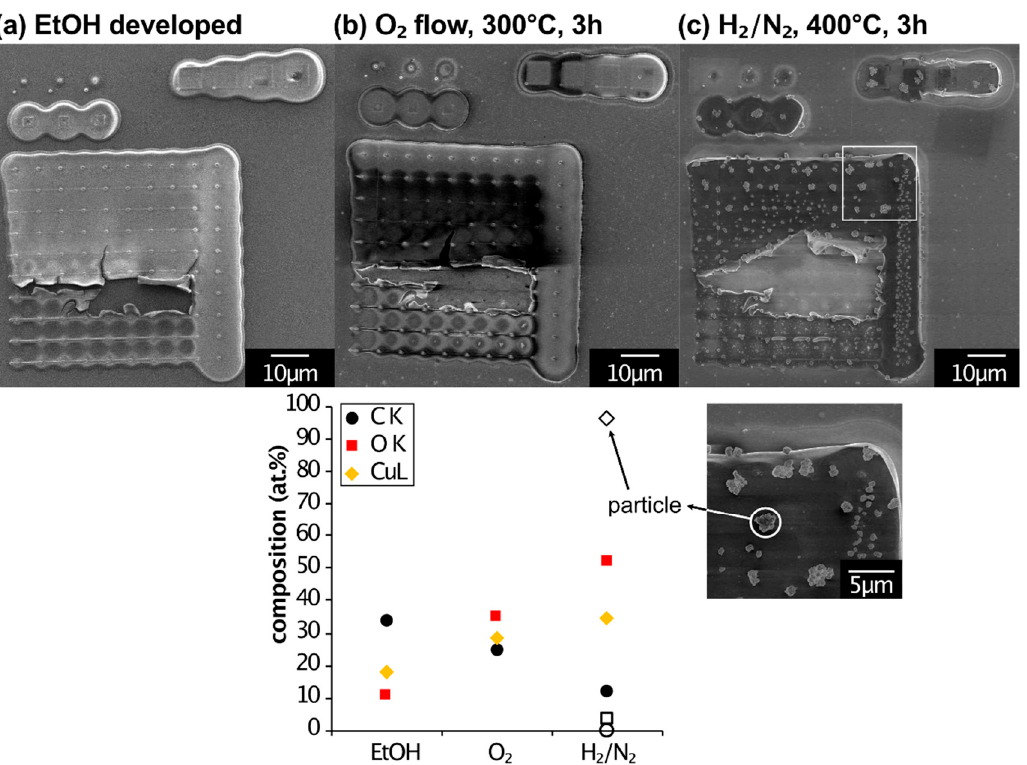
Figure 6. Post-purification of D-EBL structures in region I. ( a ) The as-deposited structure after development in EtOH. ( b ) The oxidized structure after 3 h in oxygen flow at 300 °C. ( c ) The reduced structure after 3 h in form gas at 400 °C. Large clusters have formed (see high magnification region below). The graph shows the quantification results of local EDX measurements at each processing step. The empty black data points refer to the local EDX measurement of a large cluster (see high magnification image). It consists of pure copper (96 at %).